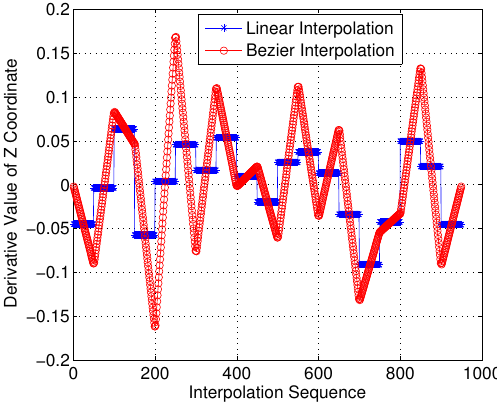
Figure 24. First-order derivative of Z -axis coordinate (case 1).